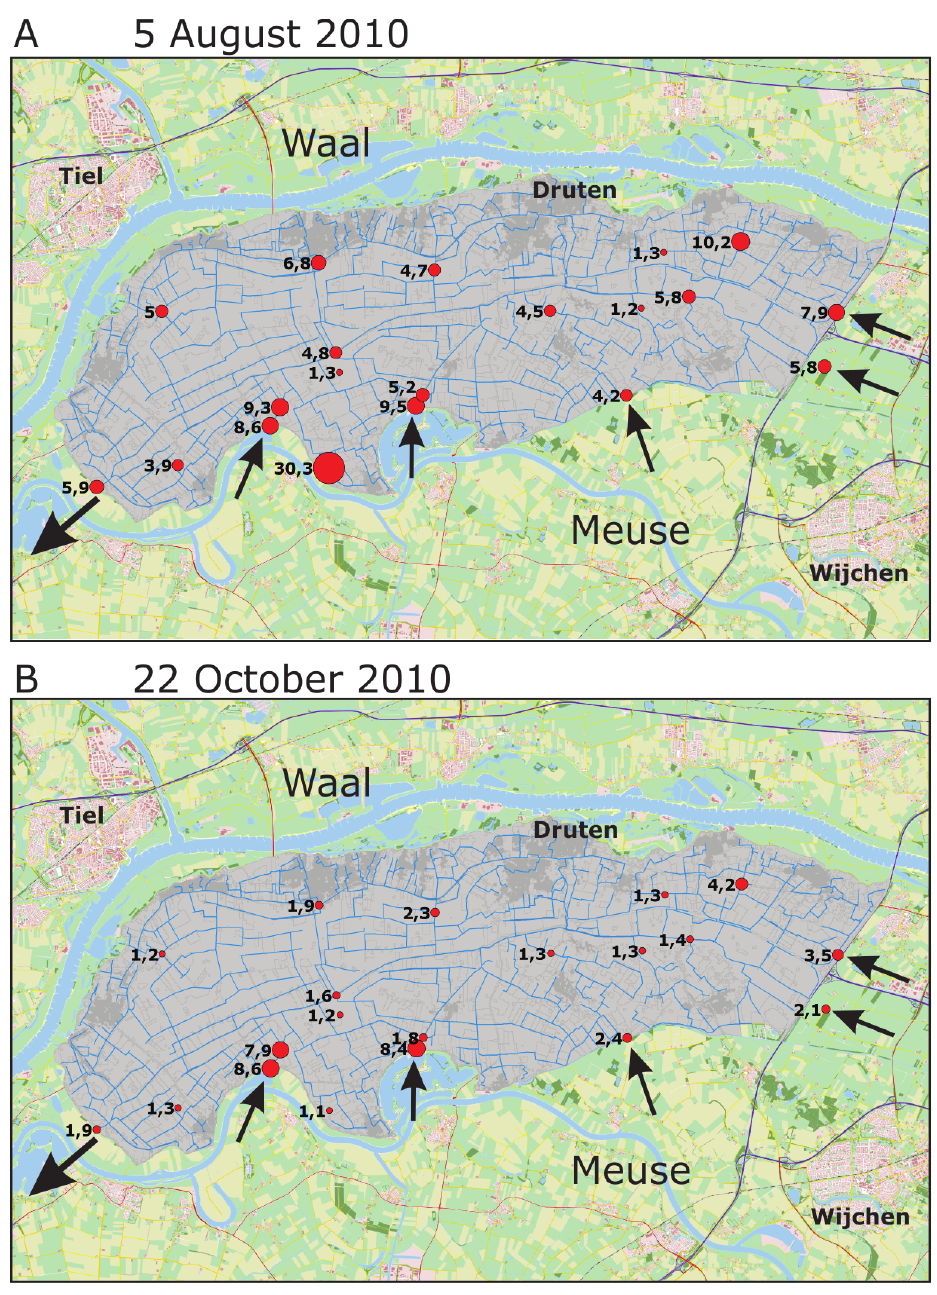
Fig. 2. Measured Gd-anomalies on (a) 5 August and (b) 22 October 2010. The arrows indicate the inlets and the outlet.